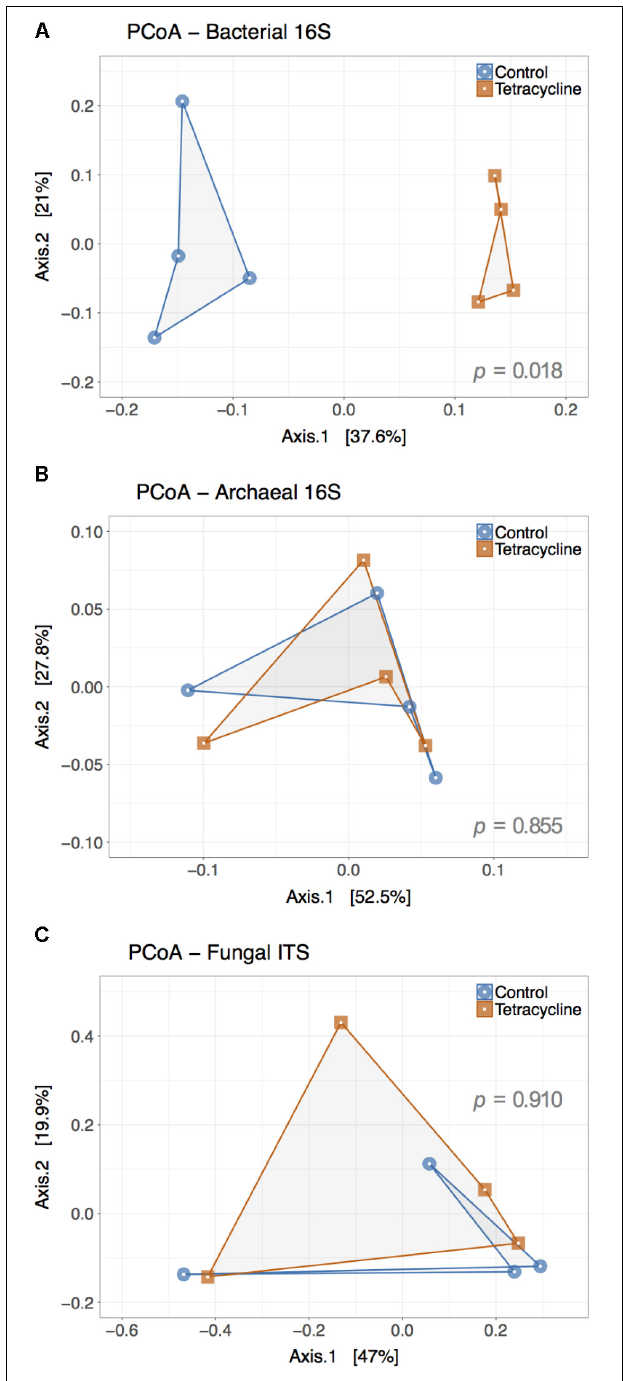
FIGURE 5 | Principal Coordinate Analysis (PCoA) plot representing the β -diversity of the bacterial (A) , archaeal (B) , and fungal (C) communities from control (blue) and tetracycline (red) samples. Both bacterial and archaeal communities were examined based on 16S rRNA gene sequences while ITS sequences were used for fungal communities. Sample dissimilarity and distance analysis was calculated using the Bray–Curtis dissimilarity index. Significant effects ( p < 0.05) of the treatment in OTU dissimilarity were tested by multivariate permutational ANOVA (PERMANOVA) and the p -values are shown in each